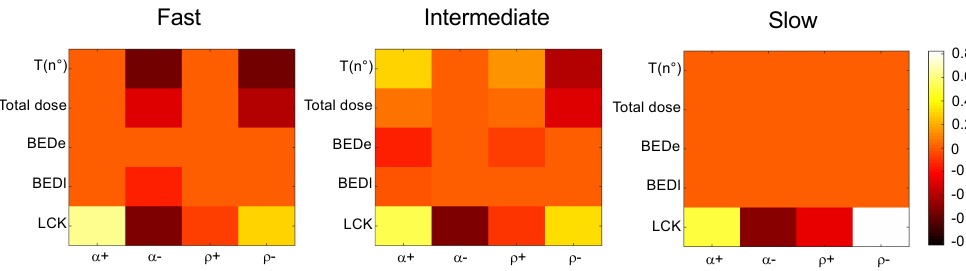
Figure 7. Sensitivity of optimal fractionated protocols to ± 50% variations of α and ρ around the nominal values, for the considered tumor classes. Nominal parameter values: ρ = 10 Gy, α = 0.35 Gy − 1 , T K = 21 days, and T P = 3 days ( Fast ); ρ = 6 Gy, α = 0.2 Gy − 1 , T K = 28 days, and T P = 14 days ( Intermediate ); and ρ = 1.5 Gy, α = 0.1 Gy − 1 , T K = 35 days, and T P = 28 days ( Slow ). d M = 7